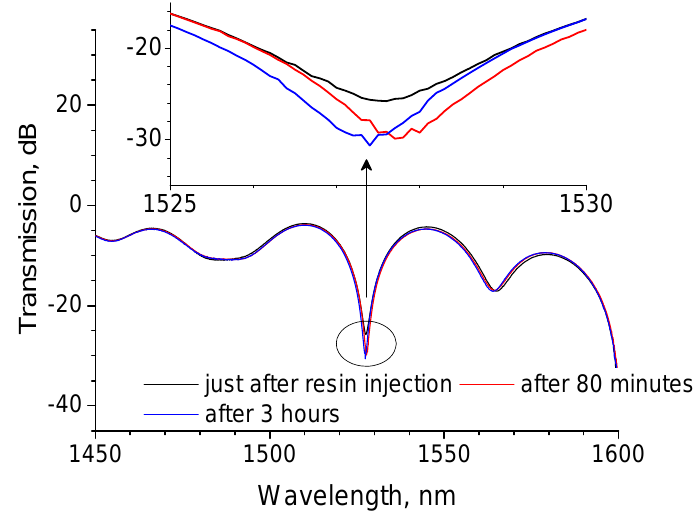
Figure 15. Change in transmission spectra of an LPG in the resin cure process in which temperature decreased gradually. The upper figure is an enlarged view of the transmission spectra in the wavelength range from 1,525 to 1,530 nm.